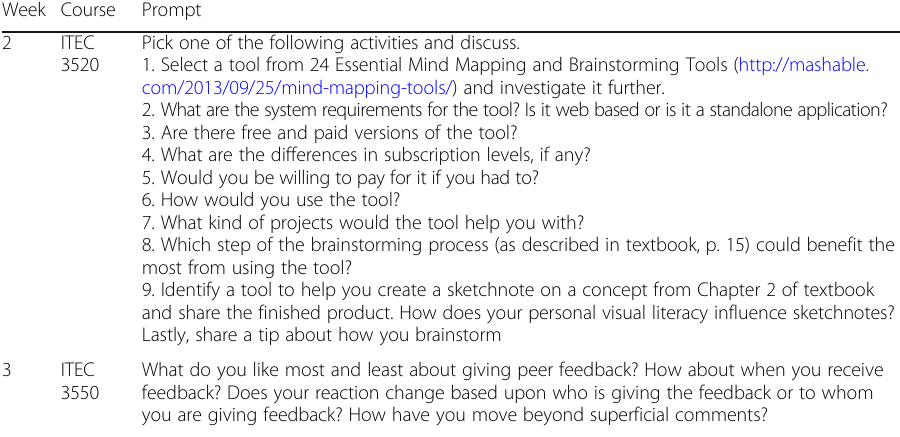
Table 3 Heuristic